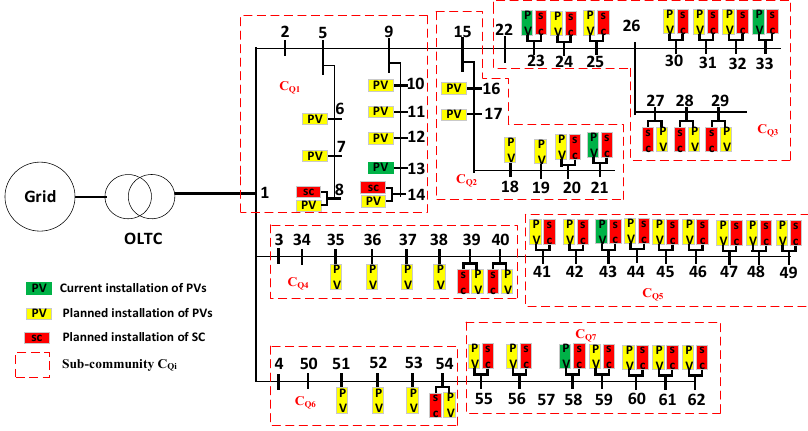
Figure 4. Topology of the real feeder under study.